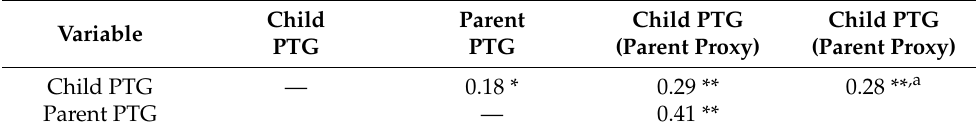
Table 2. Correlations of child and parent PTG with parent proxy reports of child PTG. Child Variable